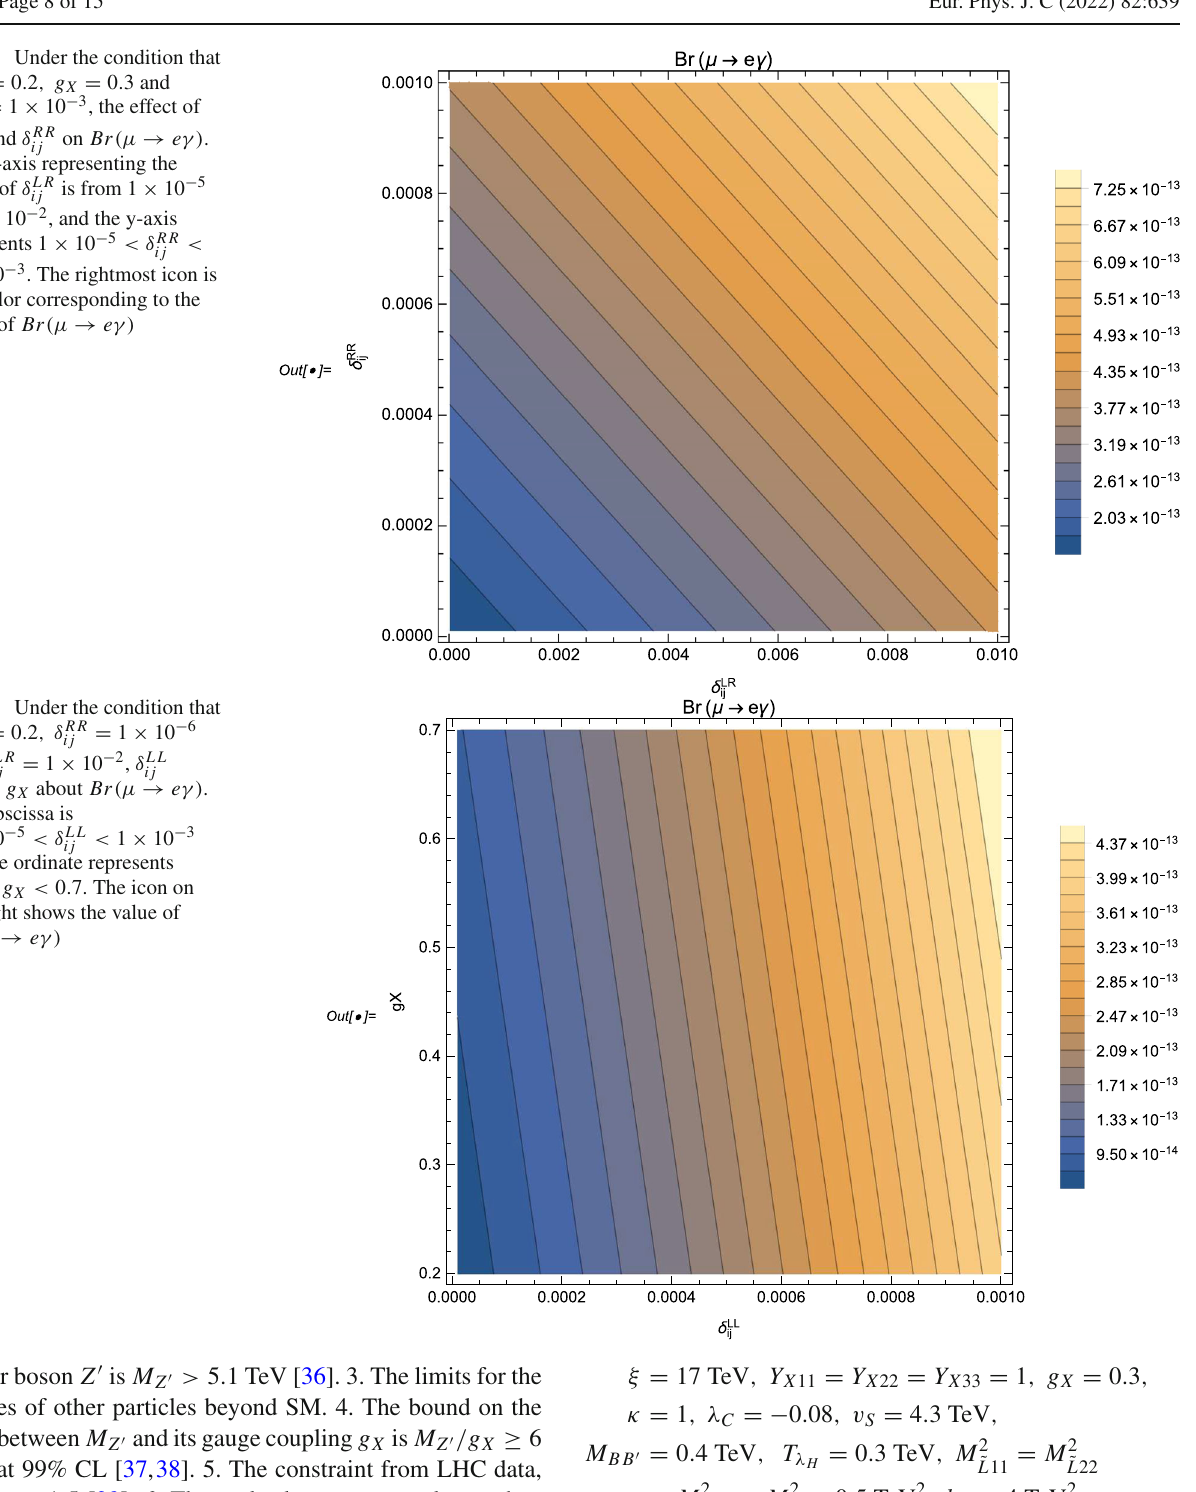
Fig. 3 Under the condition that = 1 × 10 − 6 g YX = 0 . 2 , δ RR ij = 1 × 10 − 2 , δ LL and δ LR ij ij versus g X about Br (μ → e γ) . and the ordinate represents 0 . 2 < g X < 0 . 7. The icon on the right shows the value of Br (μ → e